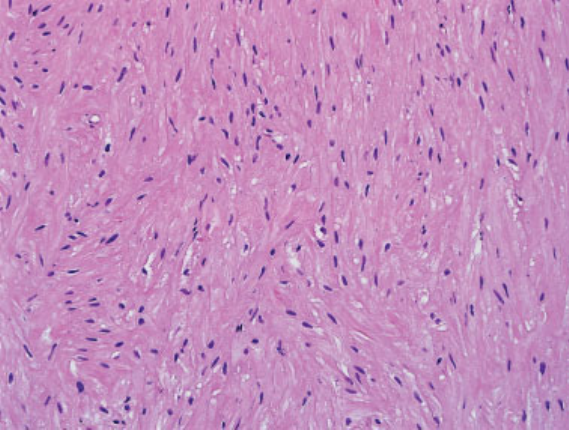
Fig. 2 Smooth muscle tumor with low cellularity. The cells form haphazard fascicles and have abundant eosinophilic cytoplasm with “ cigar-shaped ”